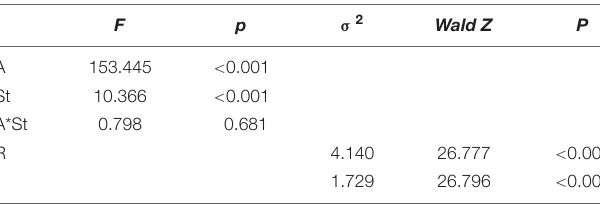
TABLE 3 | Mixed multivariate linear analysis of age and stories.